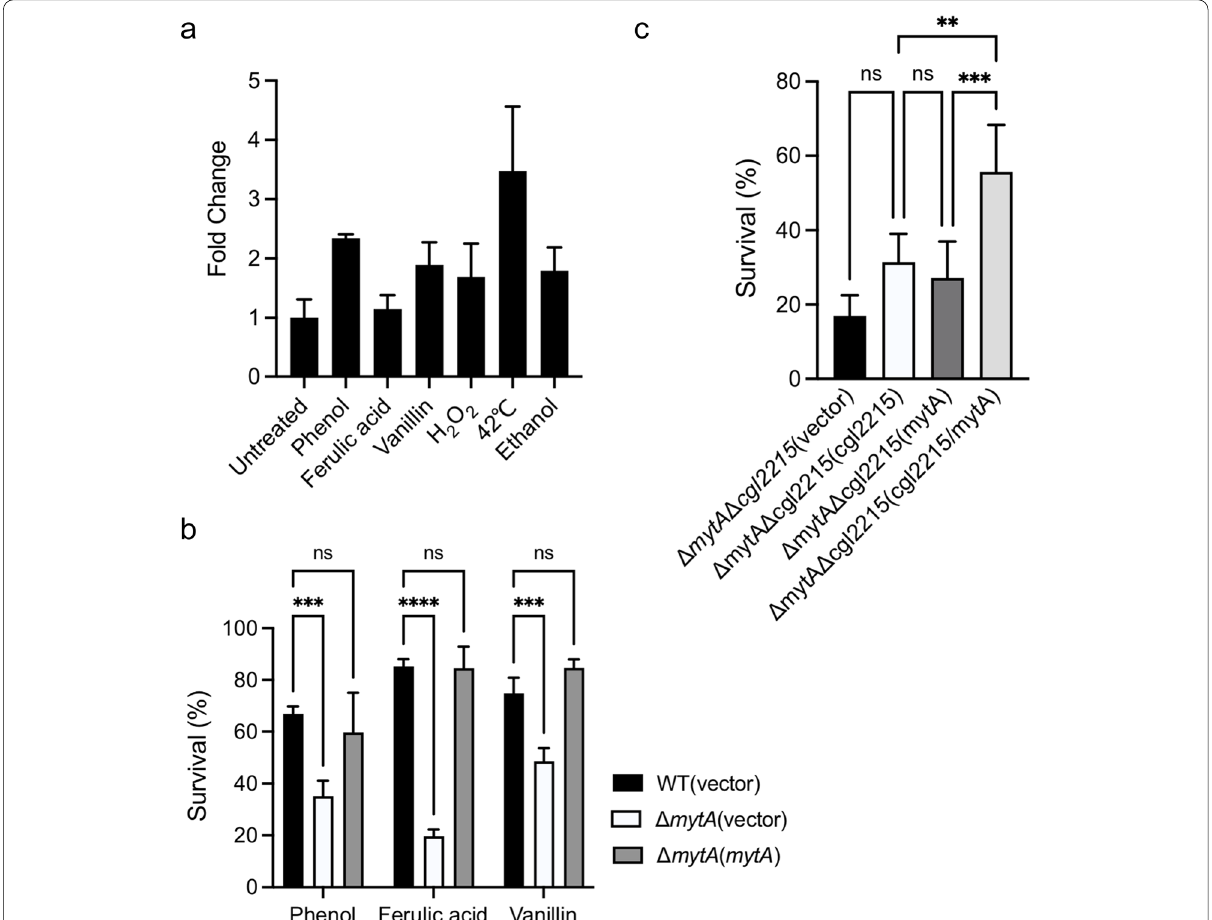
Fig. 4 MytA involved in Cgl2215-mediated tolerance to phenolic compounds in C. glutamicum . a qRT-PCR analysis of mytA transcription in C. glutamicum in response to phenol (8 mM), ferulic acid (4 mM), vanillin (6 mM), H 2 O 2 (20 mM), ethanol (1.72 M), or heat (42°C). b Effect of mytA deletion on the tolerance to phenol (50 mM), ferulic acid (8 mM), or vanillin (50 mM). c Survival rates of C. glutamicum Δ cgl2215 Δ mytA (vector) strain and its different complemented stains after exposure to phenol (50 mM) stress for 30 min. The mean values and SD from at least three repeats are shown. ** P < 0.01; *** P < 0.001; **** P <